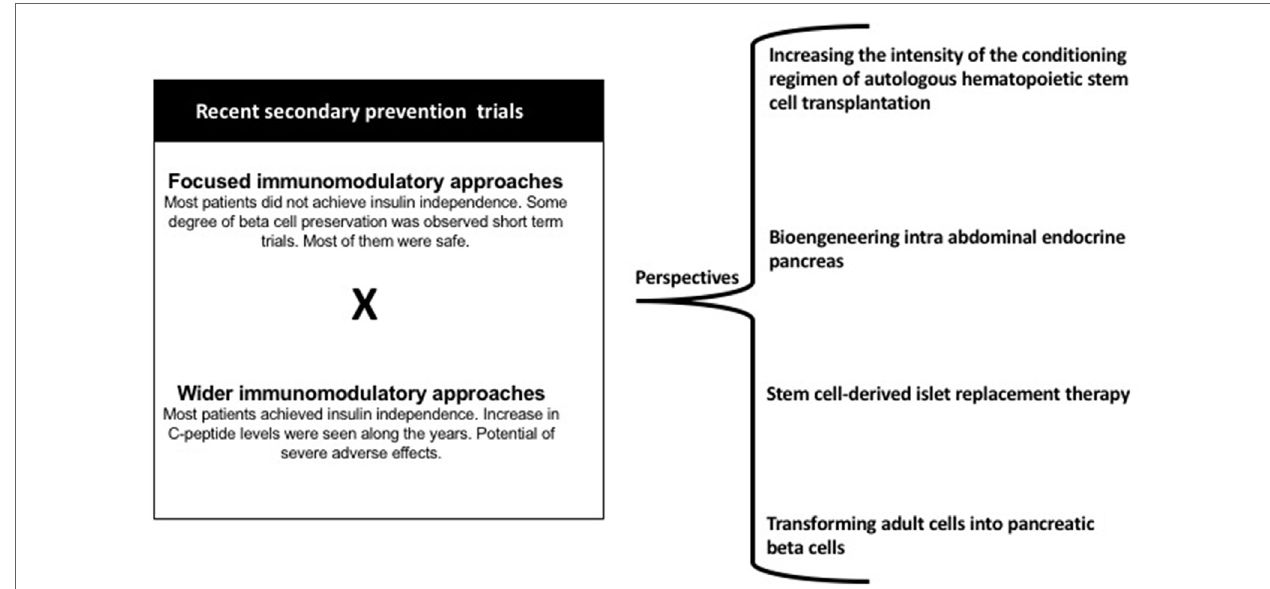
FigUre 1 | Main results of recent secondary prevention trials and perspectives in the immunologic approaches for individuals with